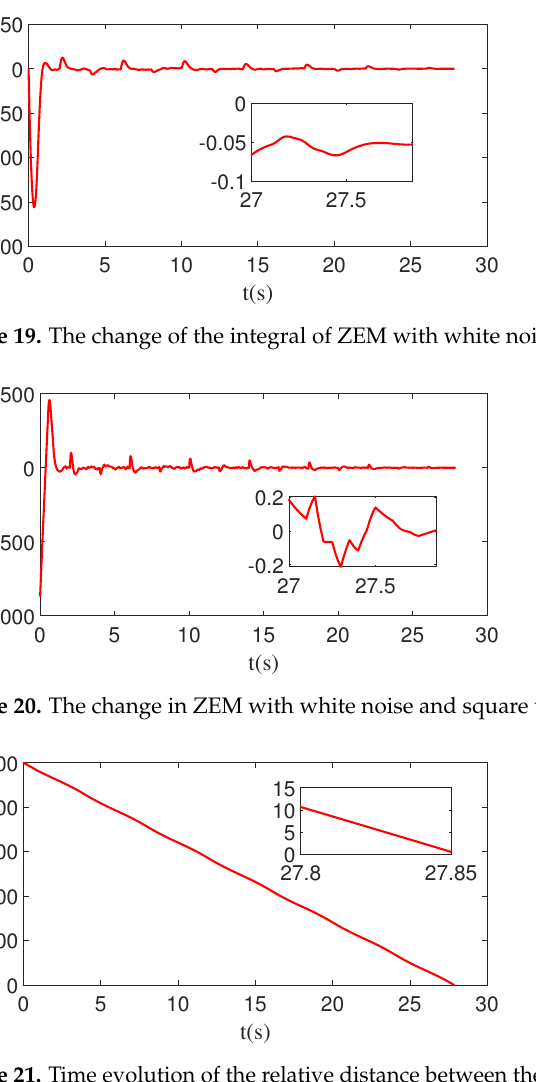
Figure 21. Time evolution of the relative distance between the missile and the target with white noise and square wave